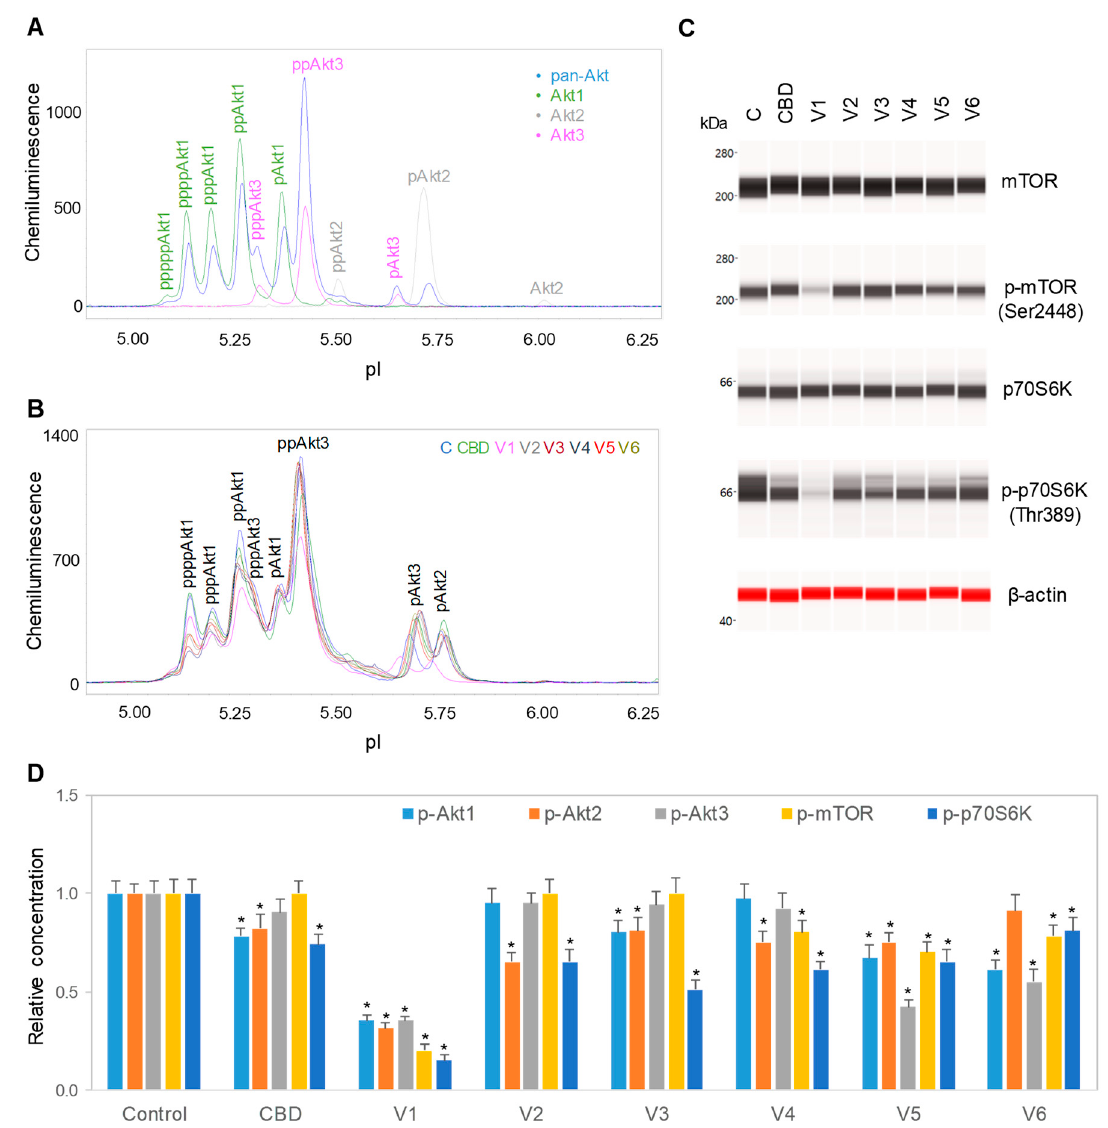
Figure 3. Downregulation of the PI3K/Akt/mTOR signaling pathway by isolated CBD and CBD oils. ( A ) AKT isoform identification in SH-SY5Y cell lysates using capillary isoelectric focusing (cIEF) immunoassays. Antibodies against total Akt (pan-Akt, blue), Akt1 (green), Akt2 (gray), or Akt3 (pink) were used to identify Akt isoforms; ( B ) the total Akt profiles of SH-SY5Y cells before (C, blue) and after 24 h of treatment with isolated CBD (green) or with various CBD oil samples, V1 (pink), V2 (gray), V3 (deep red), V4 (dark blue), V5 (red), and V6 (dark yellow); ( C ) capillary Western immunoassays using antibodies against mTOR, p-mTOR (Ser2448), p70S6K, p-p70S6K (Thr389), and β -actin (loading control). Values on the left side of the panels are molecular weights in kilodaltons (kDa); ( D ) the relative expression levels of the phosphoisoforms of Akt1 (p-Akt1, light blue), Akt2 (p-Akt2, orange), Akt3 (p-Akt3, gray), mTOR (p-mTOR (Ser2448), yellow), and p70S6K (p-p70S6K (Thr389), blue) before (control) or after 24 h of treatment with isolated CBD or CBD oil samples V1-V6. Relative concentration describes fold change of protein phosphoisoforms after treatment as compared with the control. Error bars are the standard deviations of six repeated measurements per experimental condition. Asterisks denote statistical significance for p < 0.05 versus controls. SH-SY5Y cells were treated with 6.25 µg/mL isolated CBD or CBD oils at 100 µg/mL final CBD concentration.